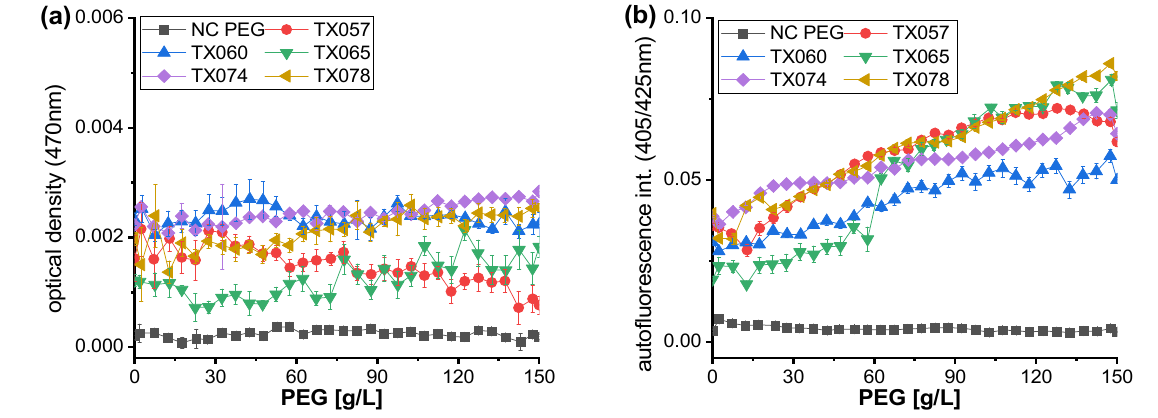
Figure 5. Dose-response curves of isolated Achromobacter spanius strains TX057, TX060, TX065, TX074 and TX078 against 600 Da PEG after 21 days of incubation ( a ) optical density of the segments measured by microphotometry and ( b ) normalized autofluorescence intensity of the segments measured by microfluorimetry. Each dot represents the mean and the error bars represent standard deviation of 10 ± 3 droplets.